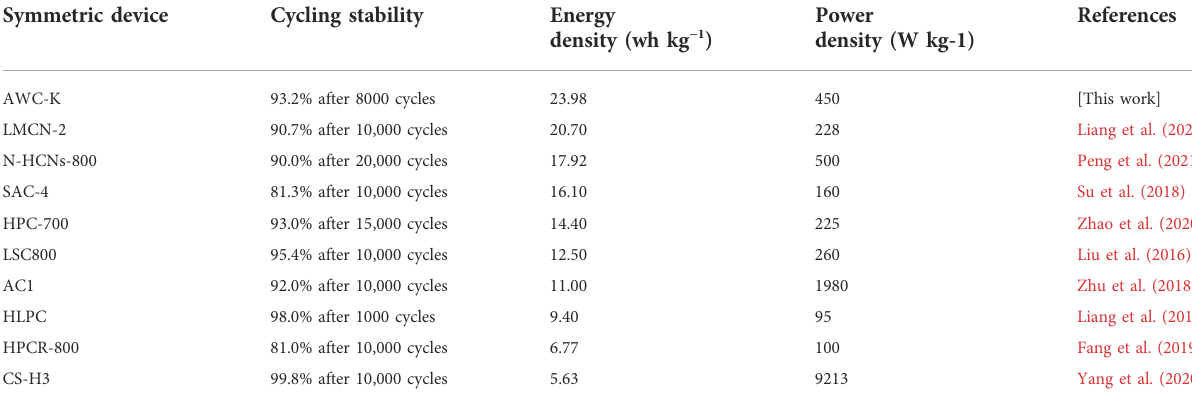
TABLE 2 Comparison of symmetric cells ’ electrochemical performance in the